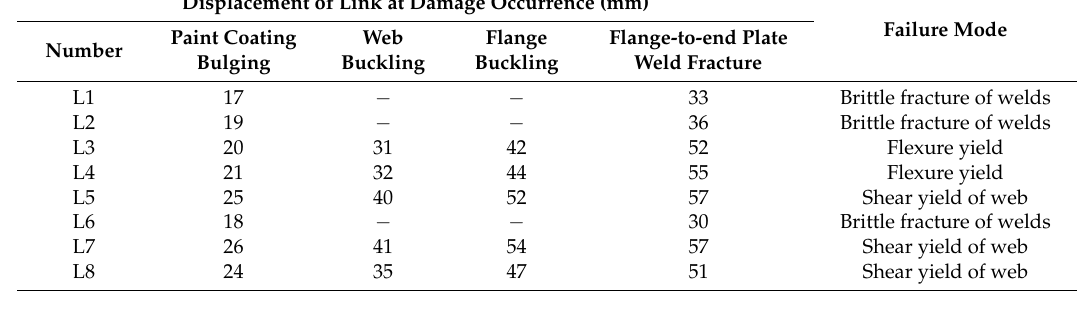
Table 3. Damage and failure process of specimens.